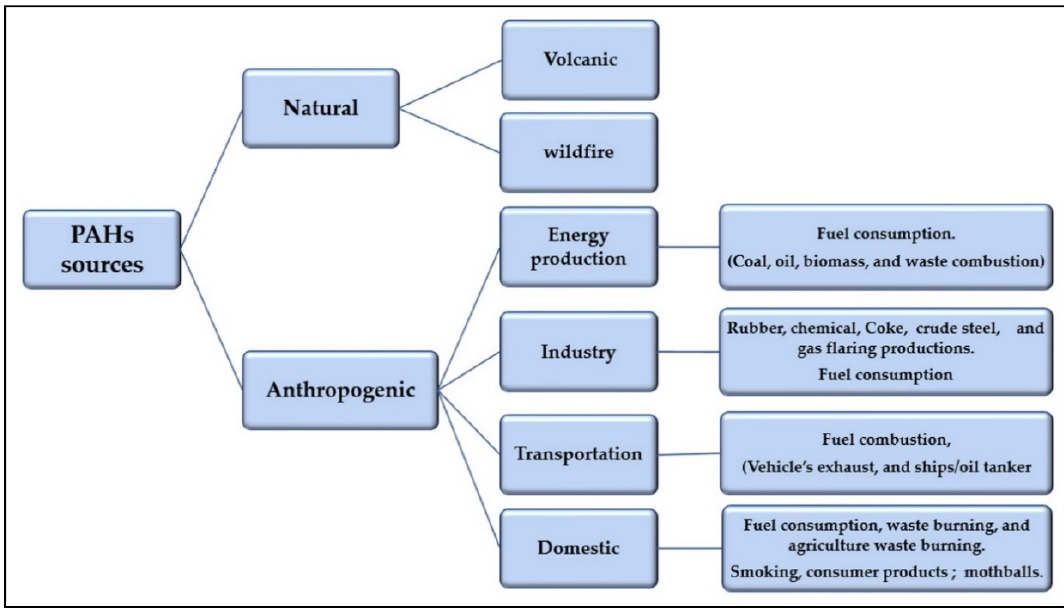
Figure 1. Different sources of polyaromatic hydrocarbons (PAHs) generation.